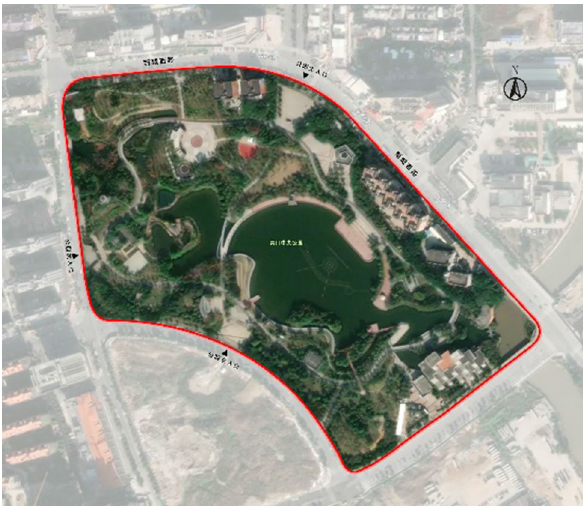
Figure 1. Schematic diagram of the Qingkou Central Park research